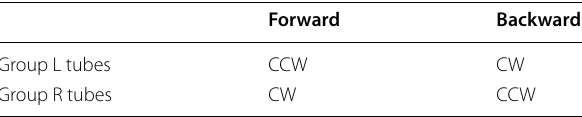
Table 1 Relationships between helical direction, locomotion, and rotation